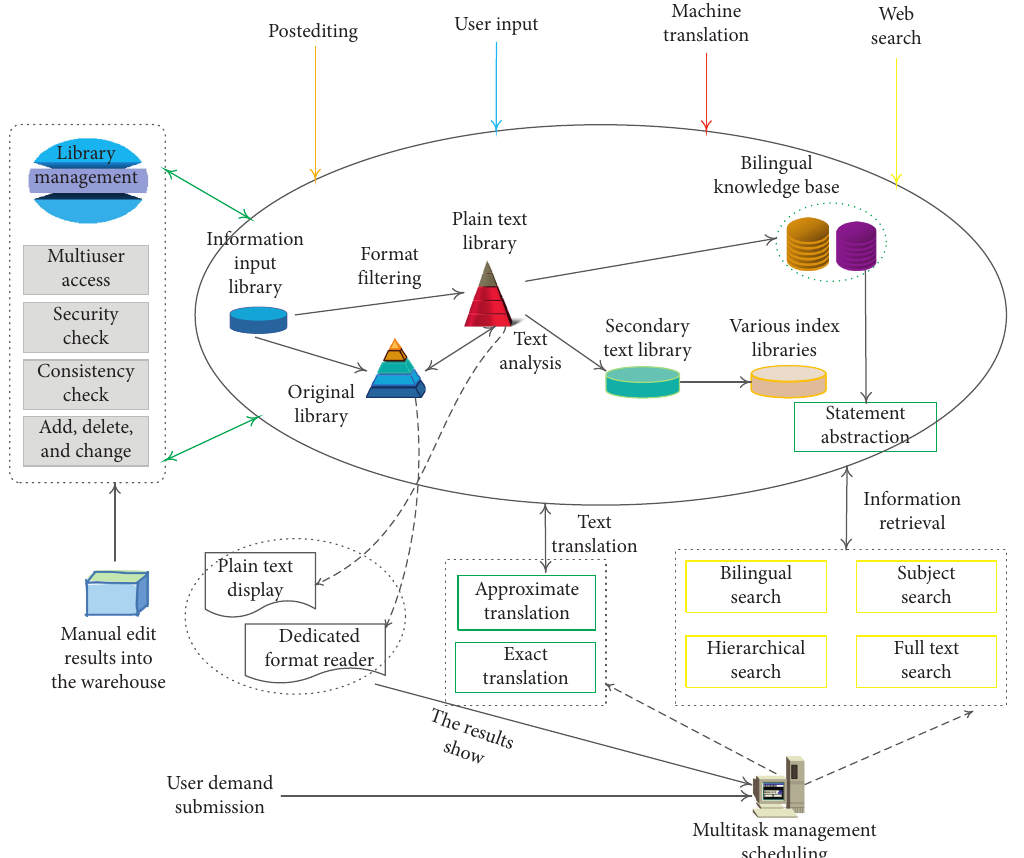
Figure 1: Network bilingual information processing system for machine